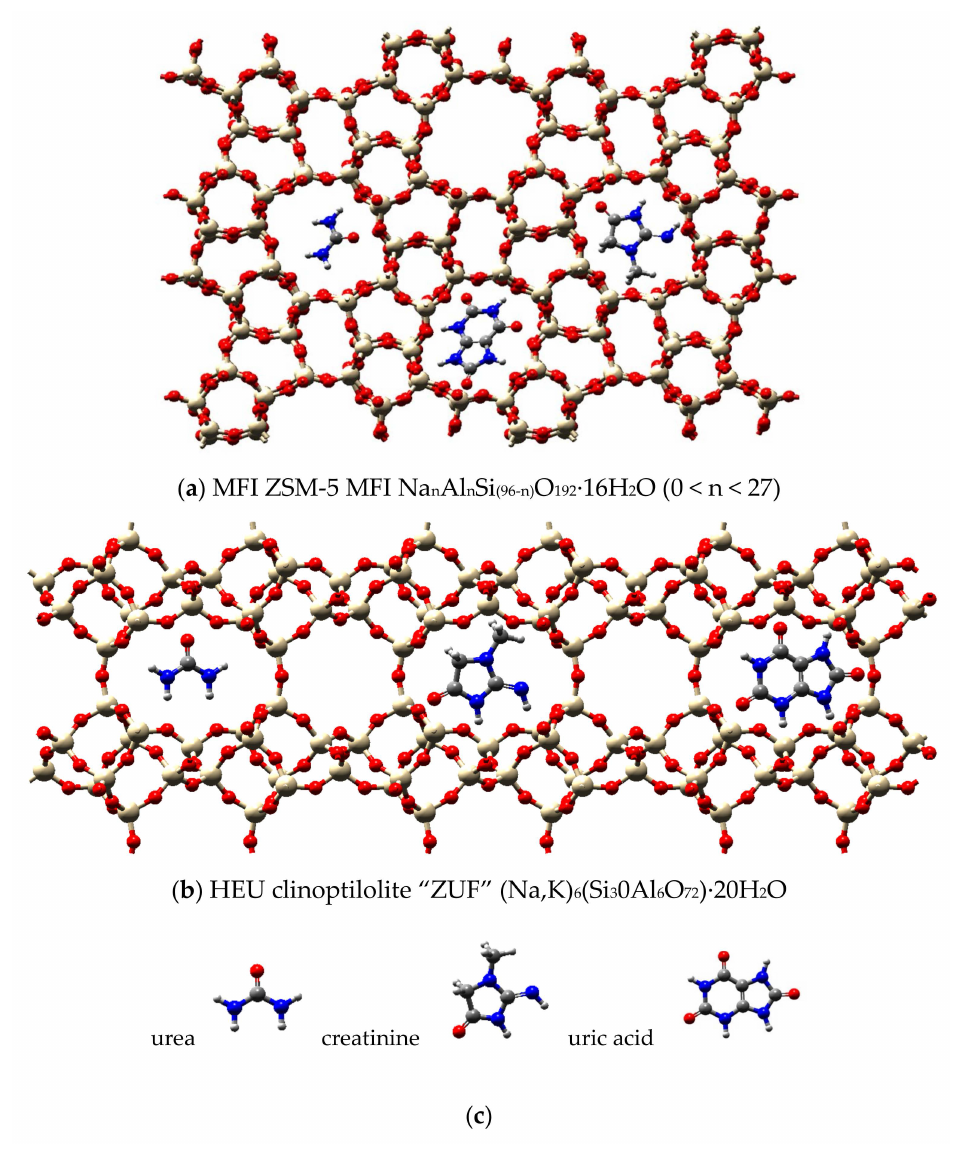
Figure 1. Molecular structures of the zeolite crystals ( a ) ZSM-5; ( b ) ZUF (clinoptilolite) Reported for reference also the structures of the uremic toxins considered ( c